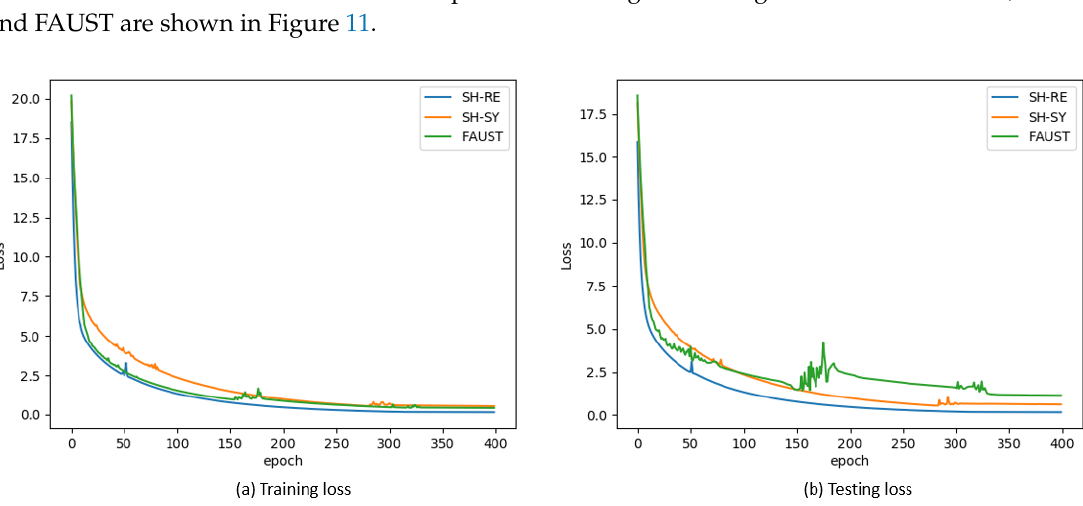
Figure 11. Training and testing losses of pose classification on the SH-RE, SH-SY, and FAUST